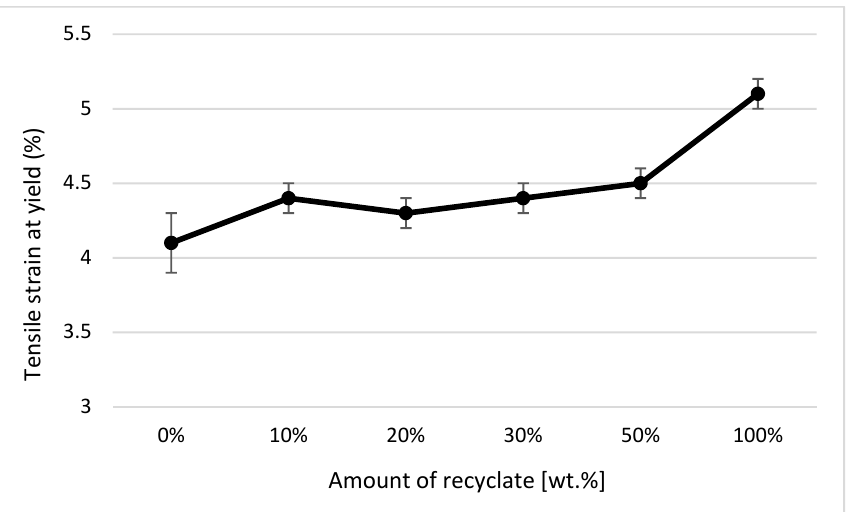
Figure 13. Dependence of the relative elongation at yield strength on the proportion of weight of the recycled material before exposing the samples to elevated temperature.